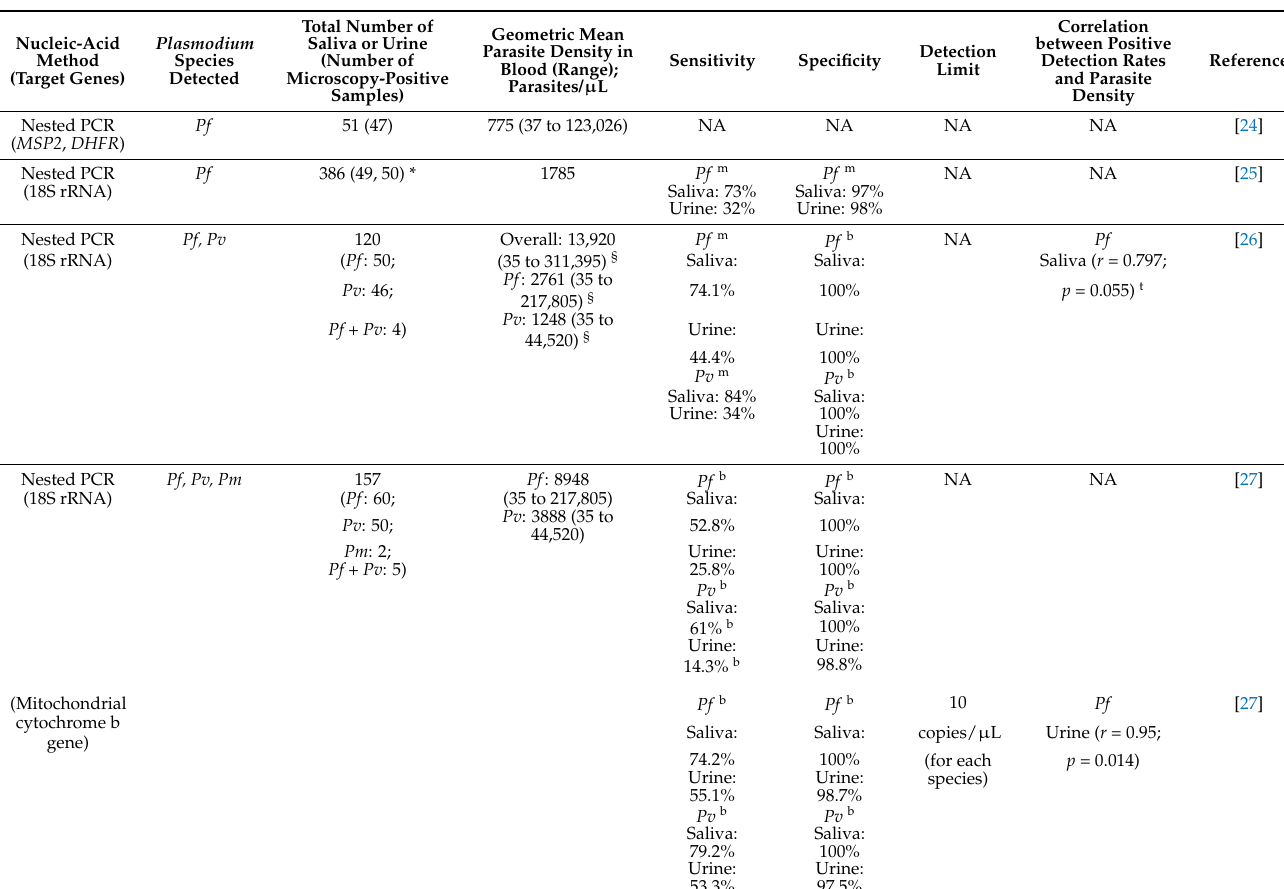
Table 1. Summary of performance of various nucleic acid diagnostic methods evaluated for Plasmodial DNA detection in saliva and urine